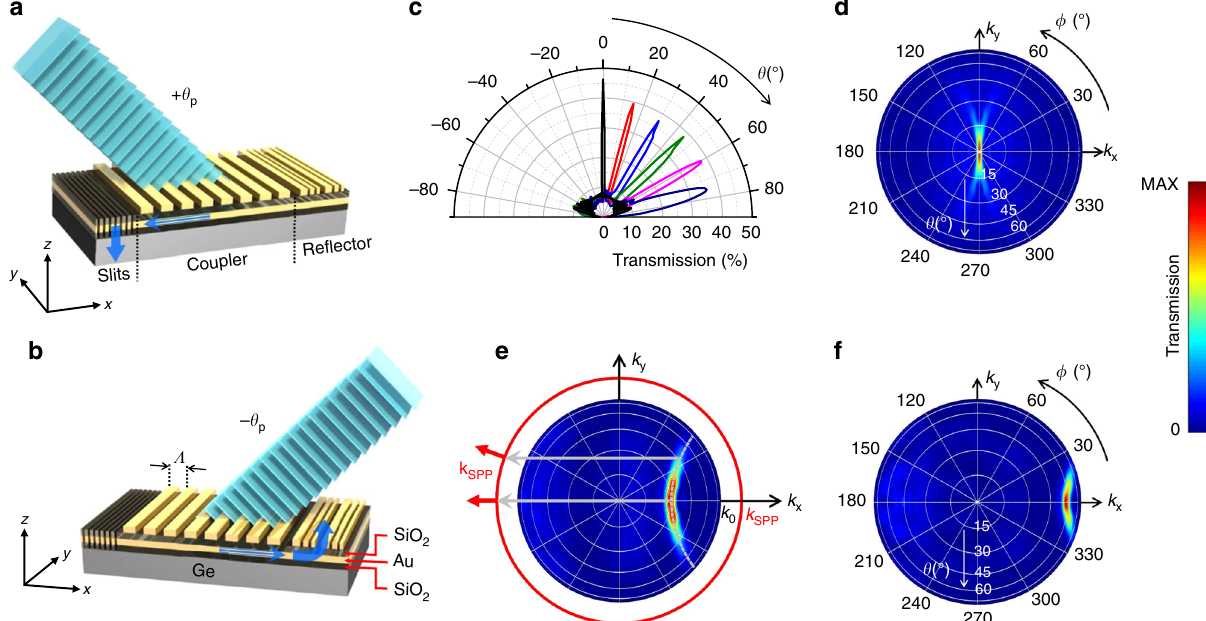
Fig. 2 Angle-sensitive metasurfaces. a , b Schematic illustrations of the metasurface geometry and principle of operation. Light incident at the desired detection angle + θ p ( a ) is diffracted by the grating coupler into SPPs propagating towards the slits, where they are preferentially scattered into the absorbing substrate. Light incident at the opposite angle − θ p ( b ) is diffracted by the NP array into SPPs propagating toward the grating re fl ector, where they are diffracted back into radiation. Light incident at any other angle is instead completely re fl ected or diffracted away from the surface. c Calculated optical transmission coef fi cient at λ 0 = 1550 nm through six different metasurfaces for p polarized light versus angle of incidence θ on the x – z plane. The grating coupler period (number of NPs) ranges from 1465 to 745 nm (15 to 29) in order of increasing angle of peak detection. The NP widths vary between 250 and 570 nm. d – f Transmission coef fi cient of three metasurfaces from c as a function of both polar θ and azimuthal ϕ illumination angles, summed over xz and yz polarizations. In each map, k x and k y are the in-plane components of the incident-light wavevector, and the color scale is normalized to the maximum (MAX) transmission value. In e , the solid red circle of radius k SPP indicates the available SPP modes on the top metal surface; the dashed curved line highlights the incident directions of peak transmission; the horizontal grey arrows (having length 2 π / Λ ) illustrate how light incident along these directions can excite SPPs by negative- fi rst-order diffraction; and the red arrows show the directions of propagation of the excited